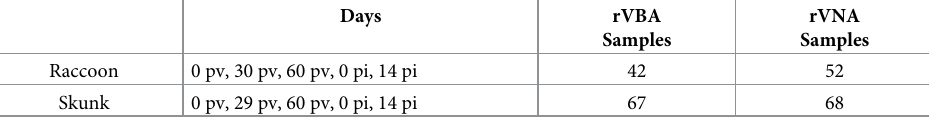
Table 1. Timeline and quantity of sera samples from vaccinated subjects used for multiple regression model building for rabies neutralizing antibody (rVNA) and rabies binding antibody (rVBA) responses. Experimental days reflect post-vaccination (pv) or post-infection